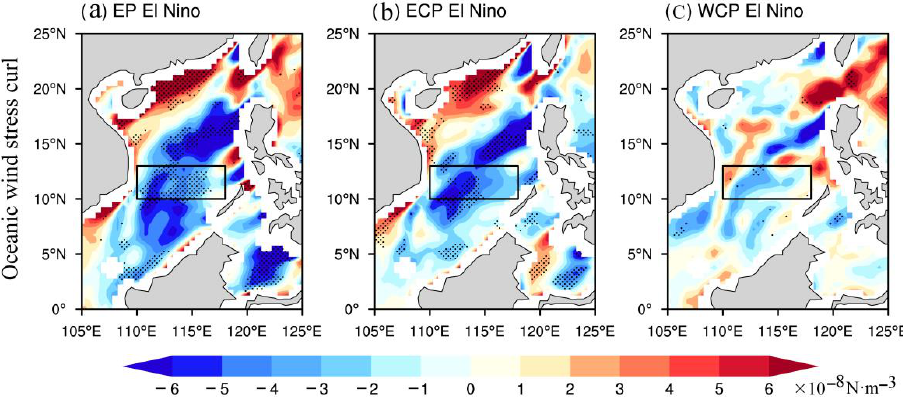
Figure 6. Composite DJF anomalies of oceanic wind stress curl (10 −8 N·m −3 ) for ( a ) the EP El Niño, ( b ) the ECP El Niño and ( c ) the WCP El Niño. The stippled areas represent the values exceeding the 90% significance level. Black rectangles represent the CT region.